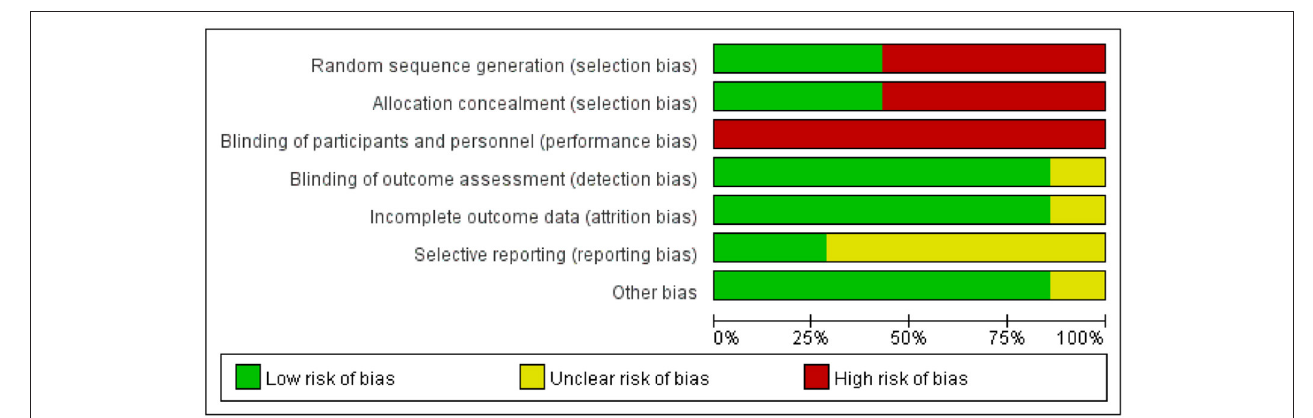
FIGURE 15 | Risk of bias graph identified in the studies included in the meta-analysis.